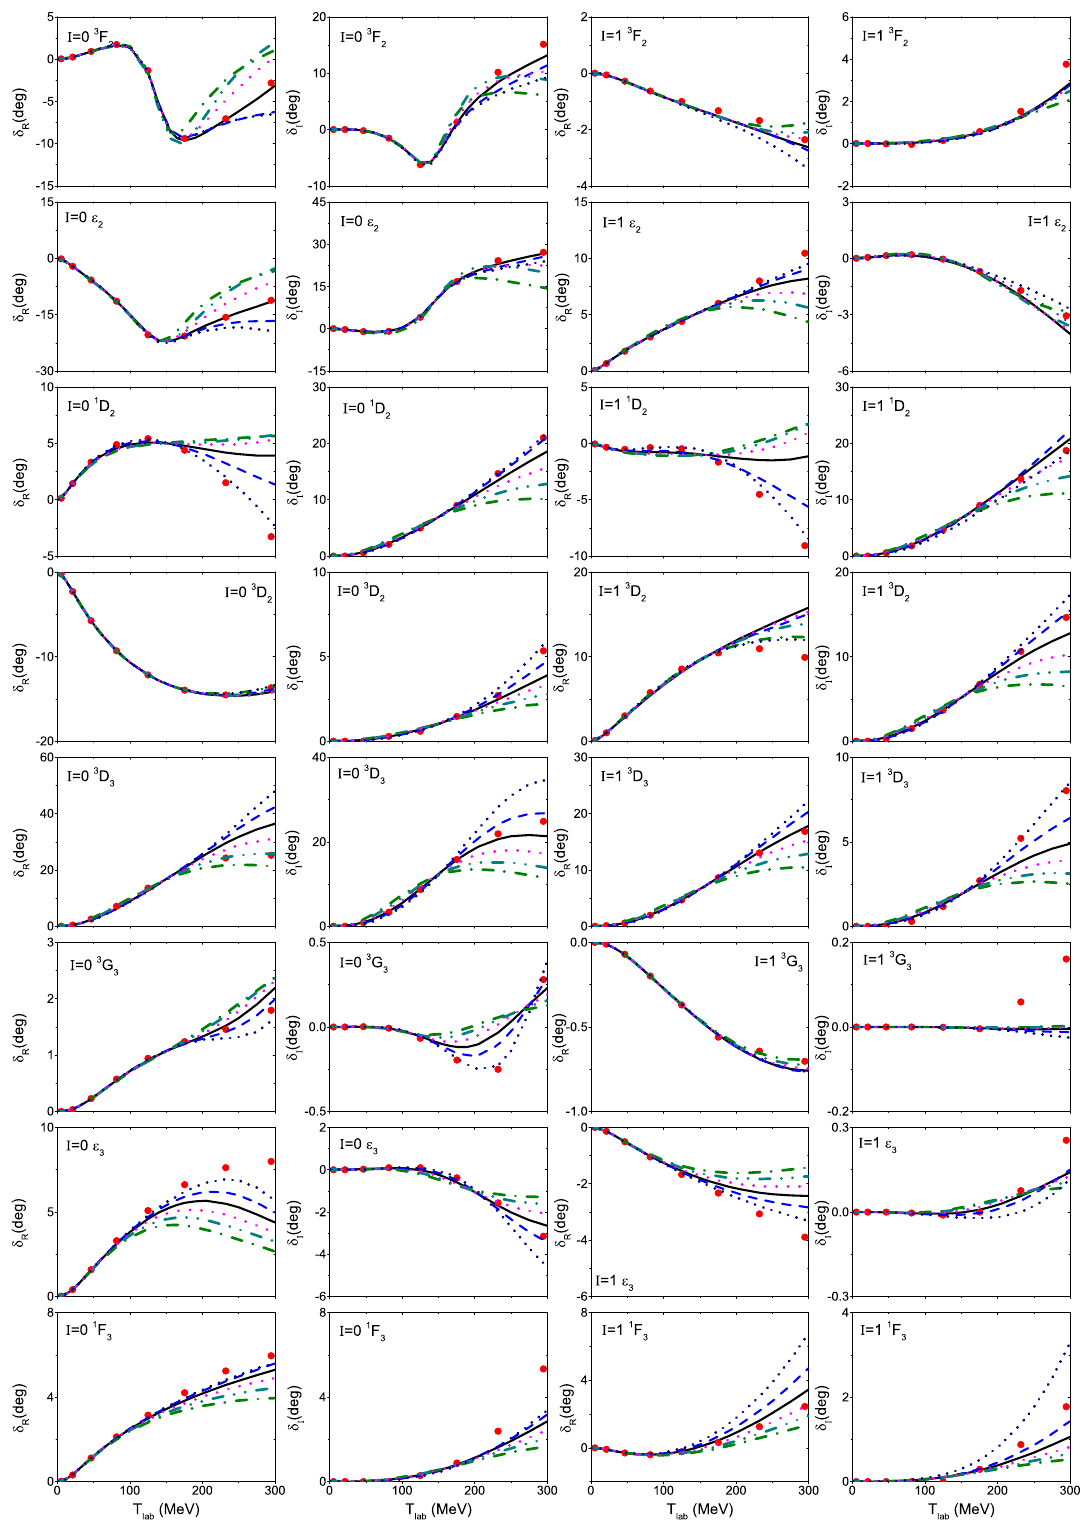
Figure 3 . Real and imaginary parts of various (cid:22) NN phase shifts at N 3 LO for cuto(cid:11)s R = 0 : 7{1 : 2 fm. The (cid:12)lled circles represent the solution of the (cid:22) pp PWA [32].